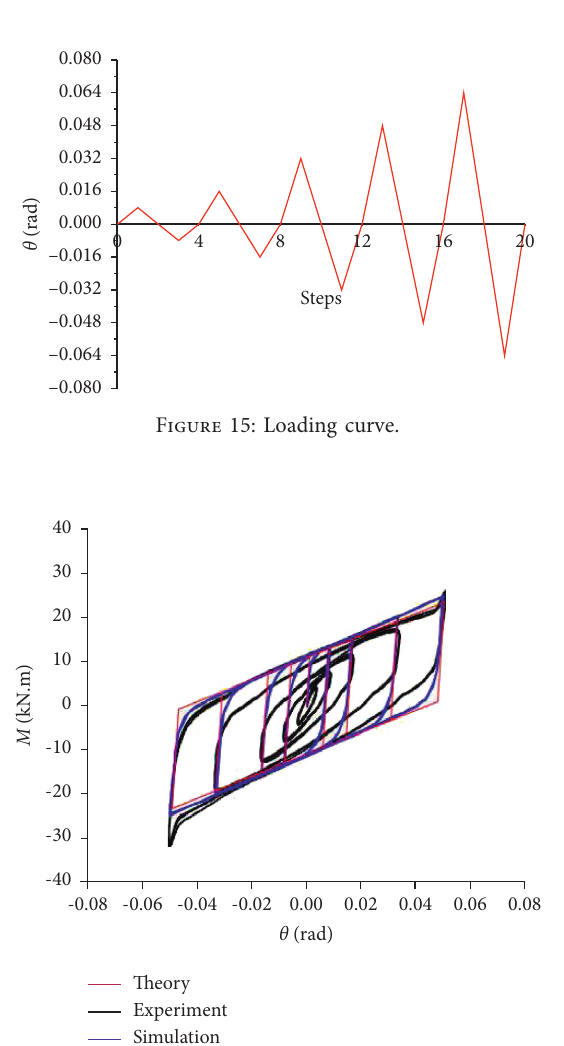
Figure 16: Comparison of the hysteresis curves between simula- tion, experiment, and